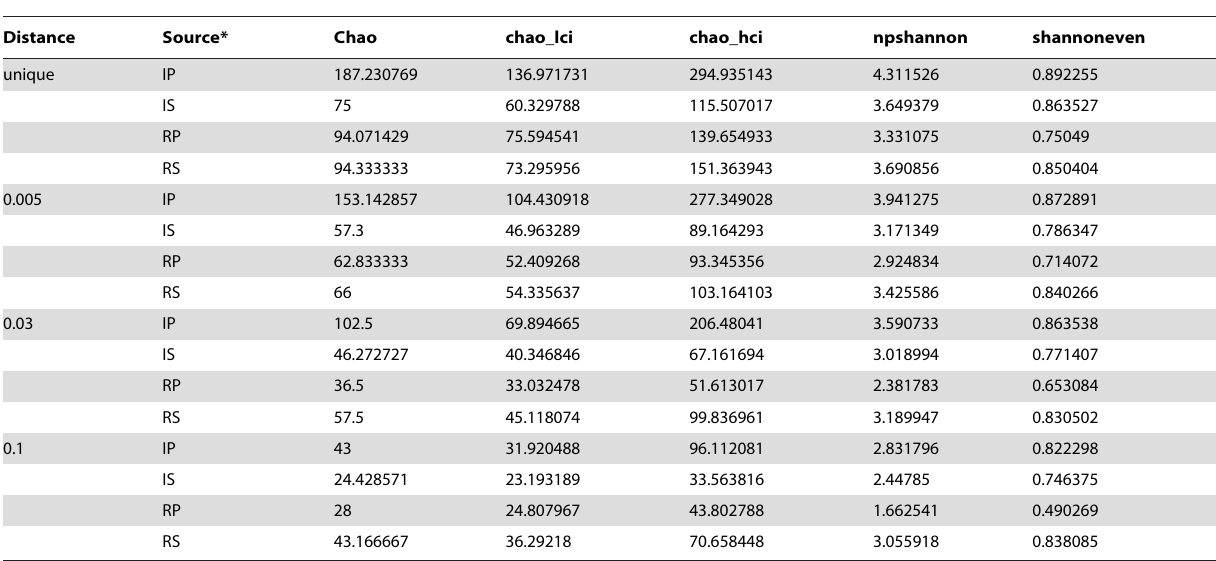
Table 2. The richness of yeasts isolated from Iriomote Island and Rishiri Island.